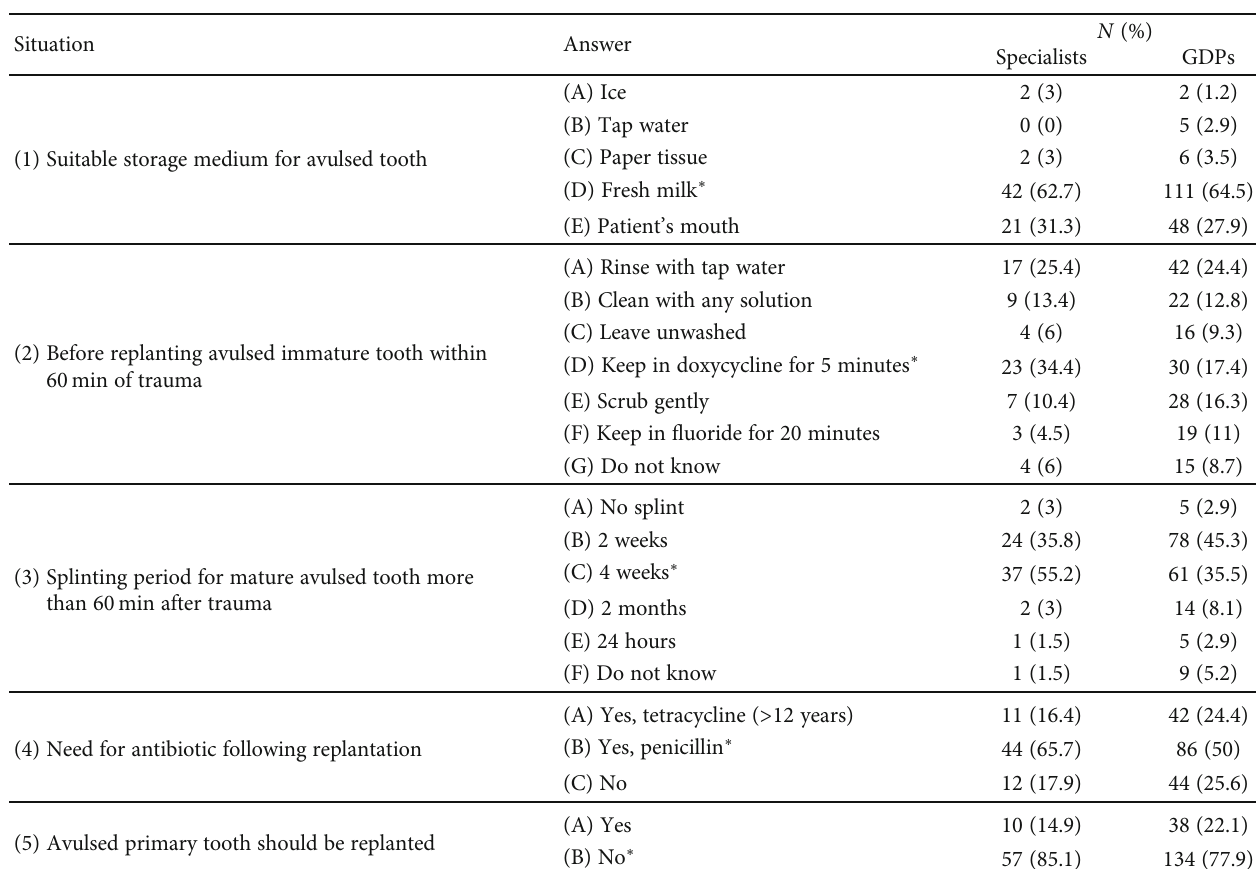
Table 4: Frequency distribution (%) of dentists ’ answers about emergency management of tooth